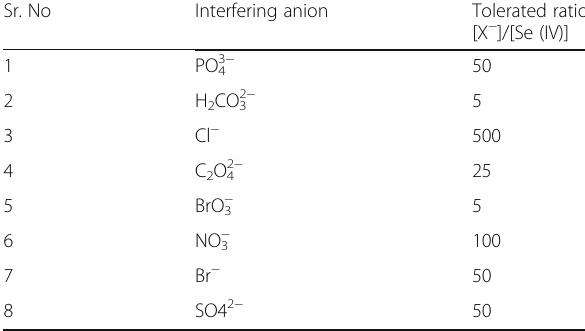
Table 1 Effect of interfering anions on Se (IV) analysis